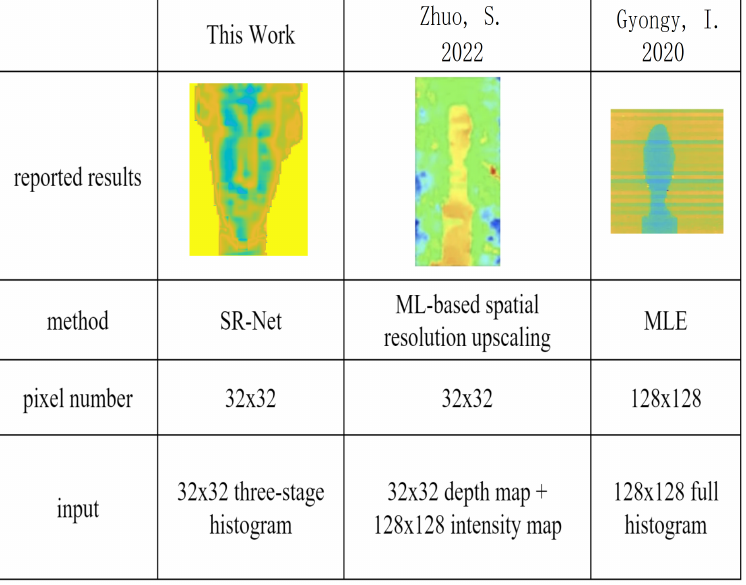
Figure 8. Performance comparison of this work with state-of-the-art dToF LiDAR systems [16] and classical dToF estimation method